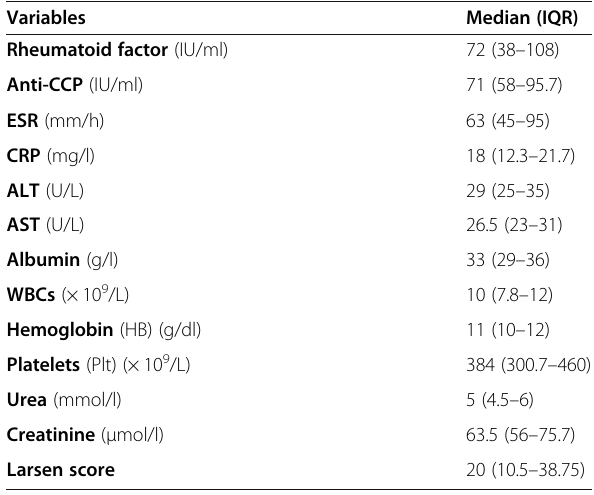
Table 2 laboratory and radiological results of the studied